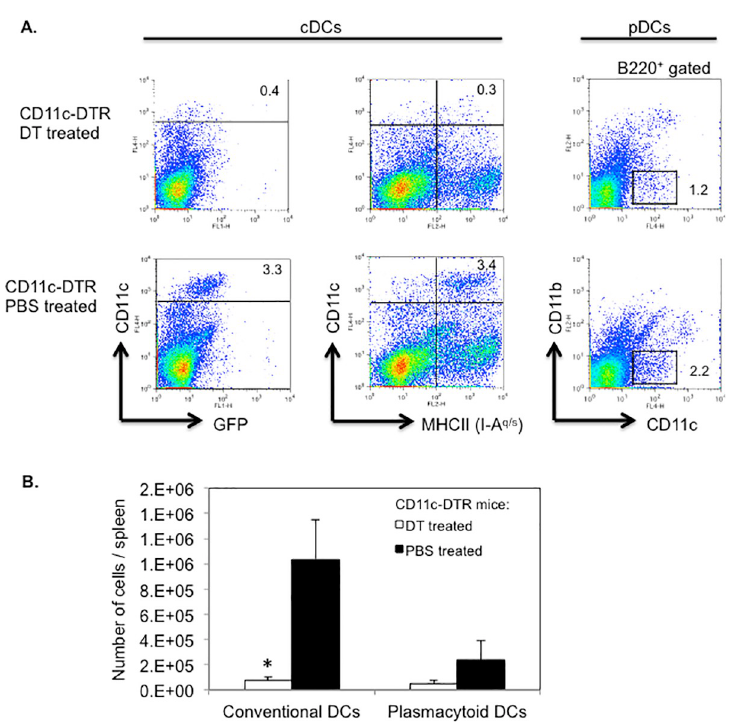
Fig 6. Efficient depletion of DCs in DT treated CD11c-DTR SJL mice. CD11c-DTR SJL mice were injected on two consecutive days with DT or PBS (2–3 mice/group). (A) Following the final injection, spleen cells from mice were isolated and assessed for cDCs (CD11c hi MHC II + or CD11c hi GFP + ) or pDCs (CD11c lo B220 + CD11b - ) by flow cytometry. Representative data of two independent experiments are shown. Numbers in dot plots refer to percentages of DC subpopulations. (B) Absolute numbers of cDCs (CD11c hi MHC II + ) and pDCs (CD11c lo B220 + CD11b - ) in DT treated or PBS treated mice. Data are shown as mean number of cells/spleen ± SEM from two independent experiments. � p < 0.02 (Student’s t test).